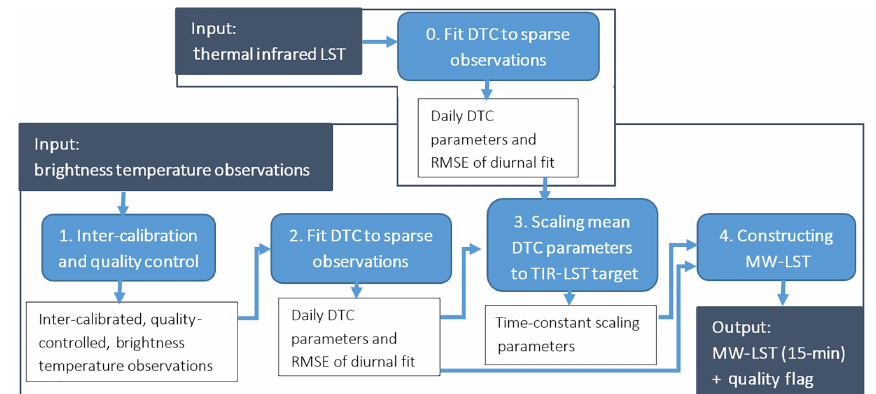
Figure 1. MW-LST